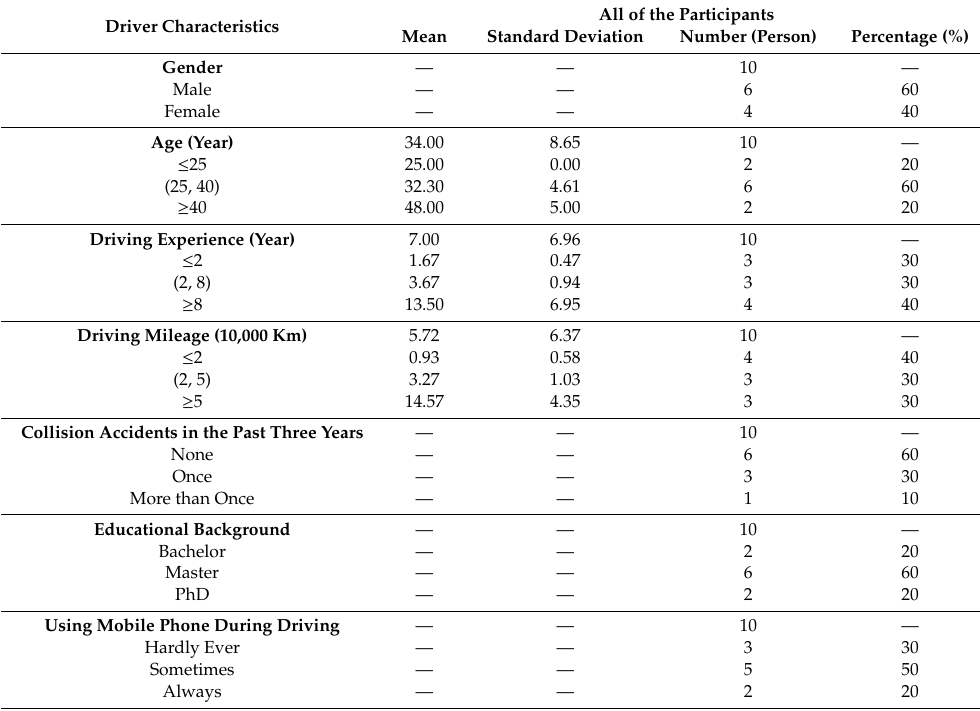
Table 1. Basic information description of the